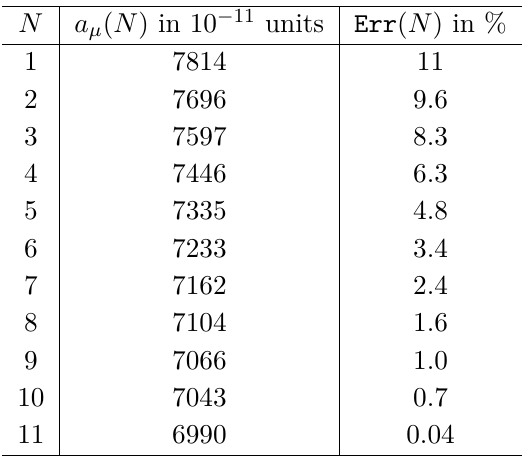
Figure 12 . Shape of the Approximants G N = 10 (red) and their matching to the model function G model ( ϕ ) which the approximants are expected to approach is in black. The red and black curves G model FO in this region are already practically identical. Notice the vertical scale in the figure.